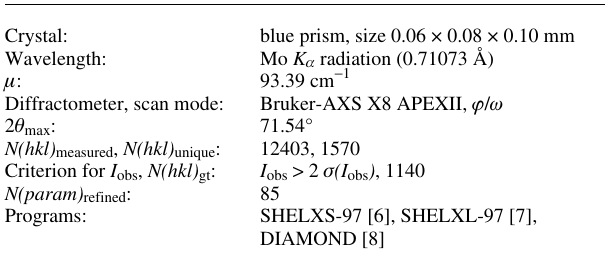
Table 1. Data collection and